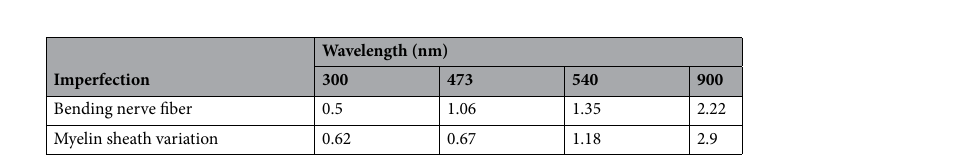
Table 4. Orders of magnitude the transmission for typical wavelengths in a bending nerve fiber and myelin sheath variation compared to a normal nerve fiber when light launched to Myelin.